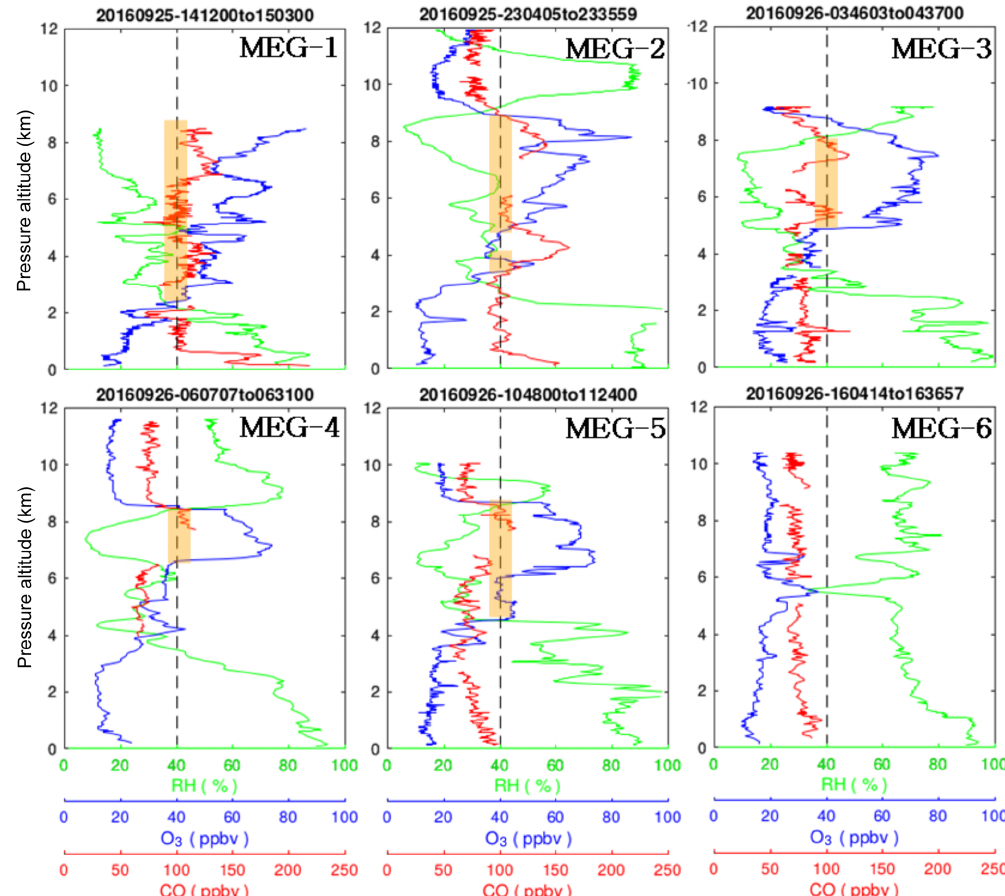
Figure 12. As in Fig. 6, except for the six take-offs from and landings to TPE of IAGOS aircraft on 25–26 September.